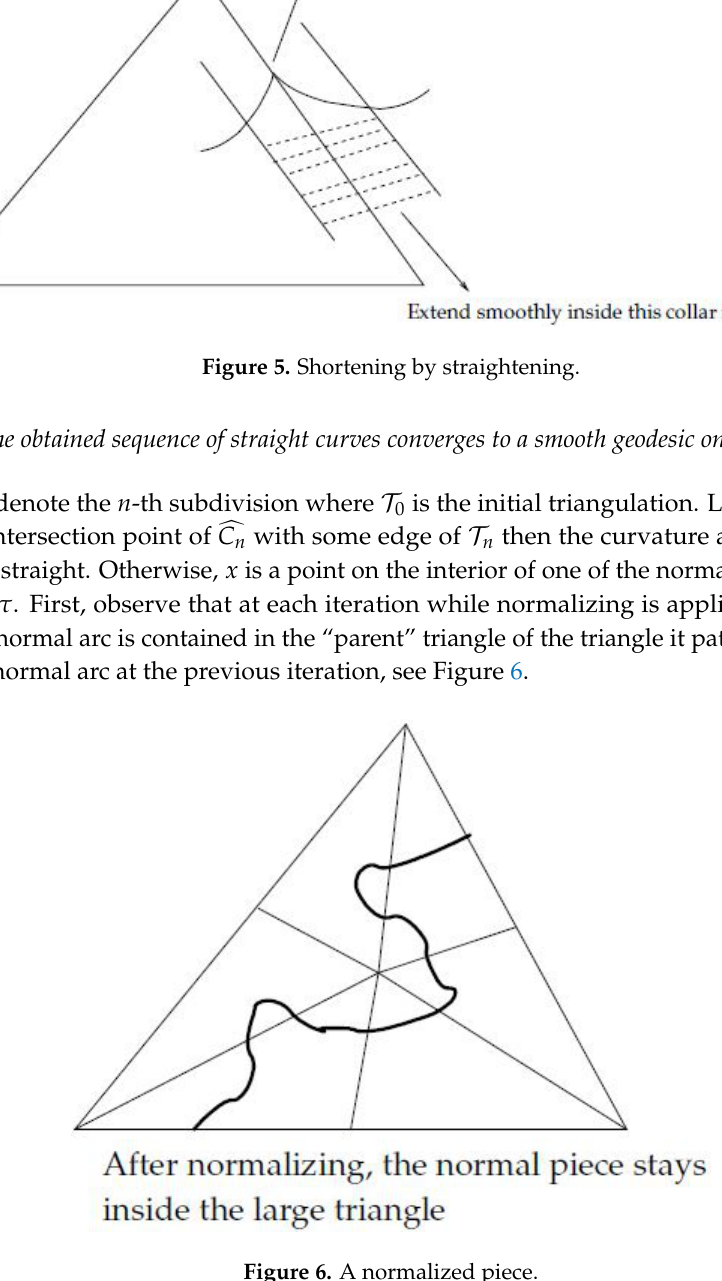
Figure 6. A normalized